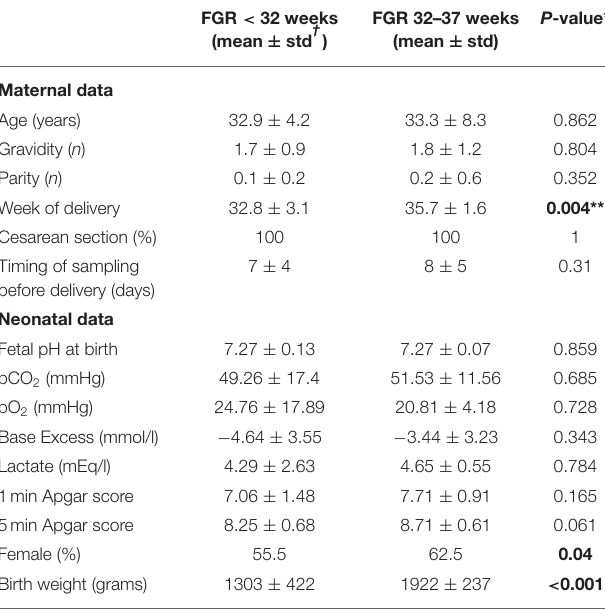
TABLE 1B | Maternal and neonatal data comparison between FGR